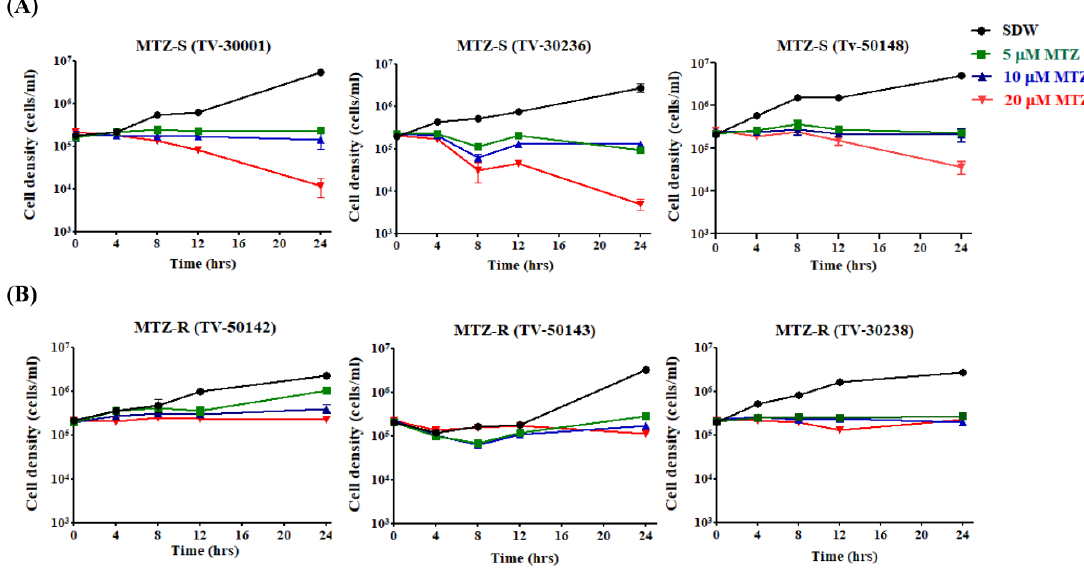
Figure 1. Validation of MTZ susceptibility of six MTZ-S and MTZ-R T. vaginalis isolates. The effect of MTZ on the growth of three MTZ-S ( A ) (Tv-30001, Tv-30236, and Tv50148) and three MTZ-R ( B ) (Tv-50142, Tv-50143, and Tv-30238) isolates was monitored. The initial concentration of MTZ-S and MTZ-R strains was 2 × 10 5 cells/mL. MTZ-S and MTZ-R trophozoites were treated with different concentrations of MTZ (5, 10, or 20 μ M) compared with the SDW-treated control. The cell density was monitored by the trypan blue exclusion assay. The growth curves were presented as mean ± SD of three independent experiments.